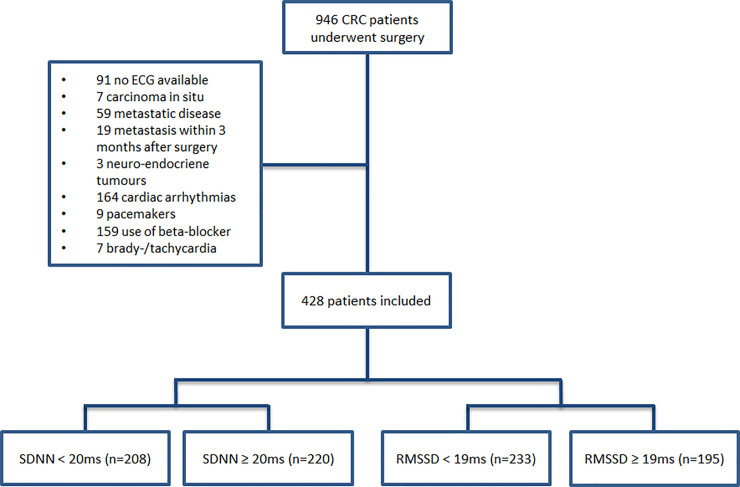
Flowchart of the study.